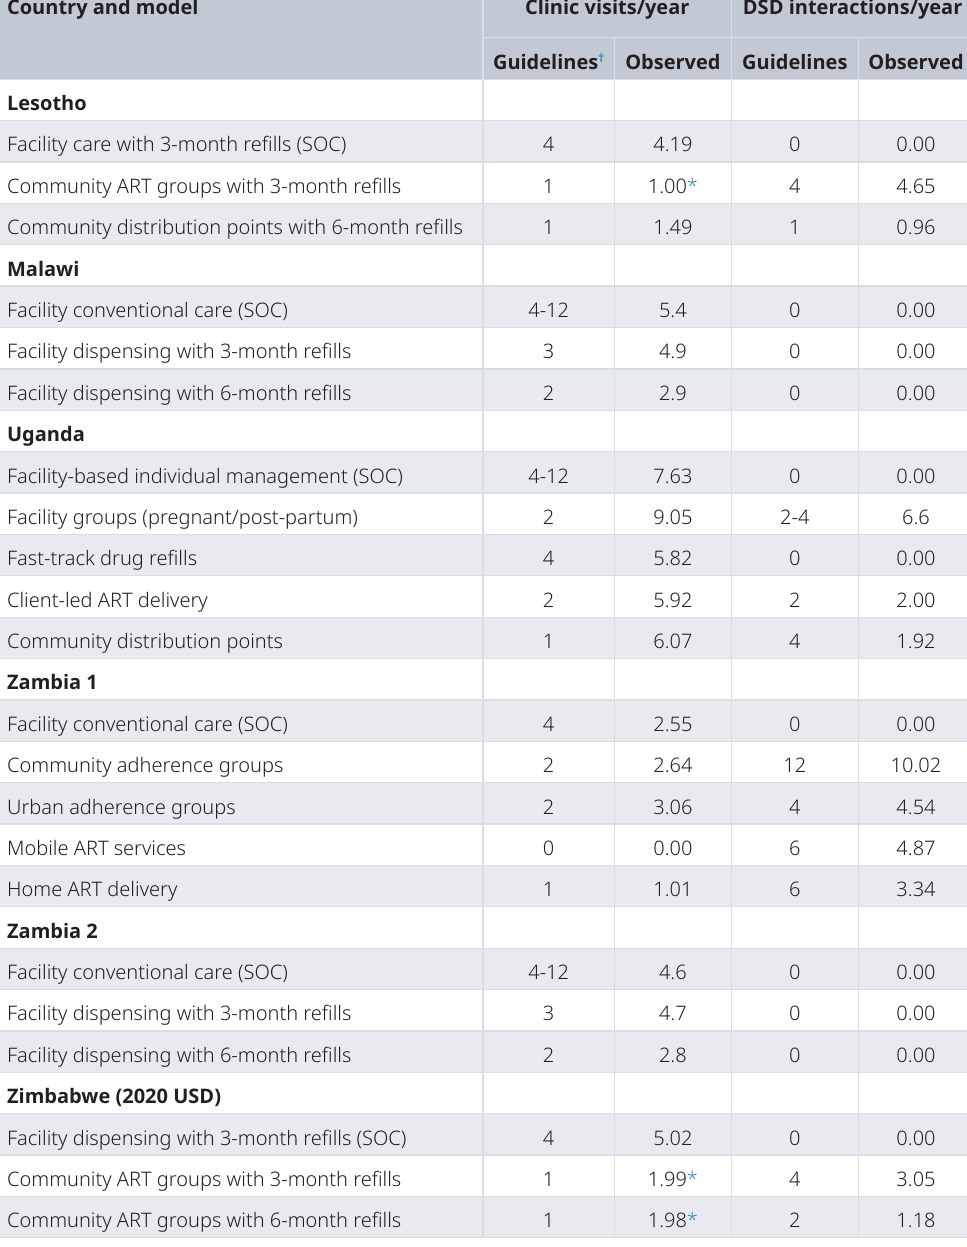
Table 4. Average number of healthcare system interactions per patient per year, guideline and observed, and average ARV dispensing